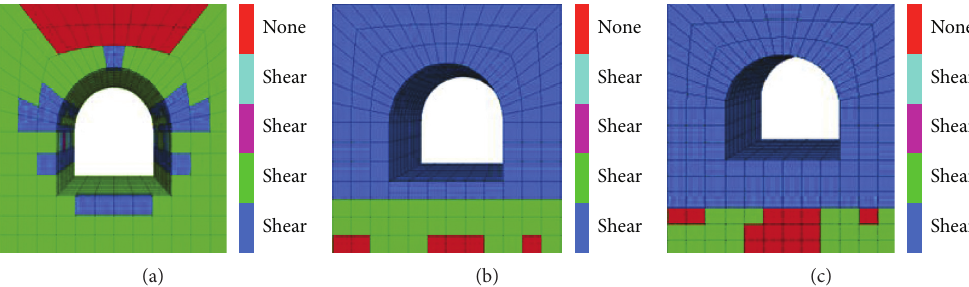
Figure 5: Plastic zone of roadway floor under different supporting conditions. (a) Plastic zone of roadway without support. (b) Plastic zone under floor corner pile. (c) Plastic zone under floor corner bolt.